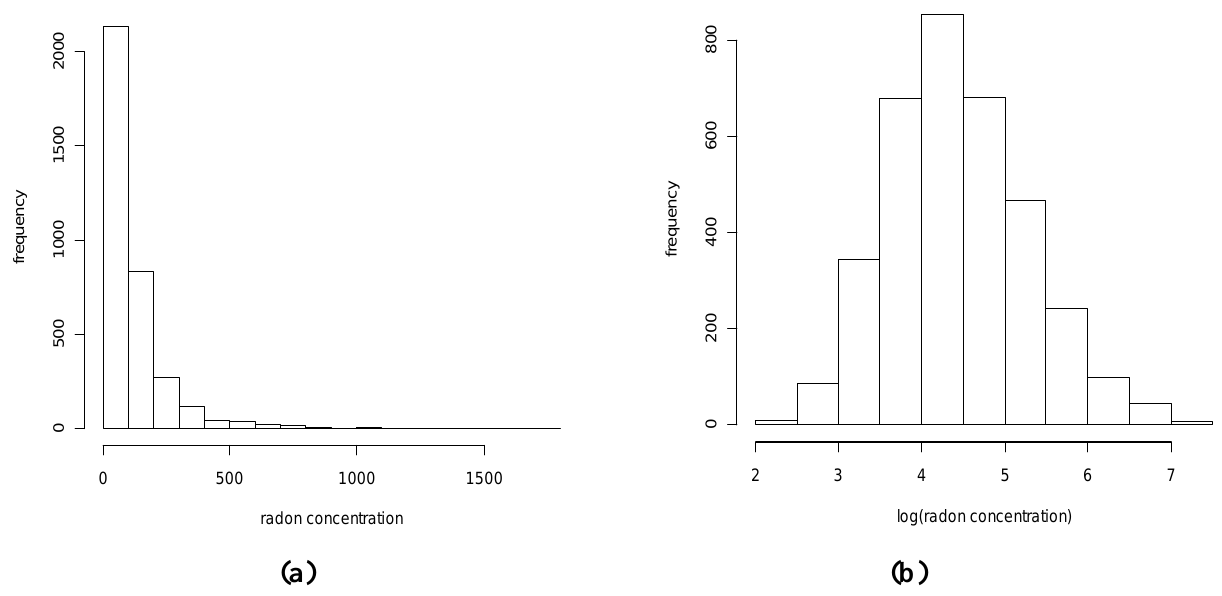
Figure 1. Histogram of IRC on (a) natural and (b) log